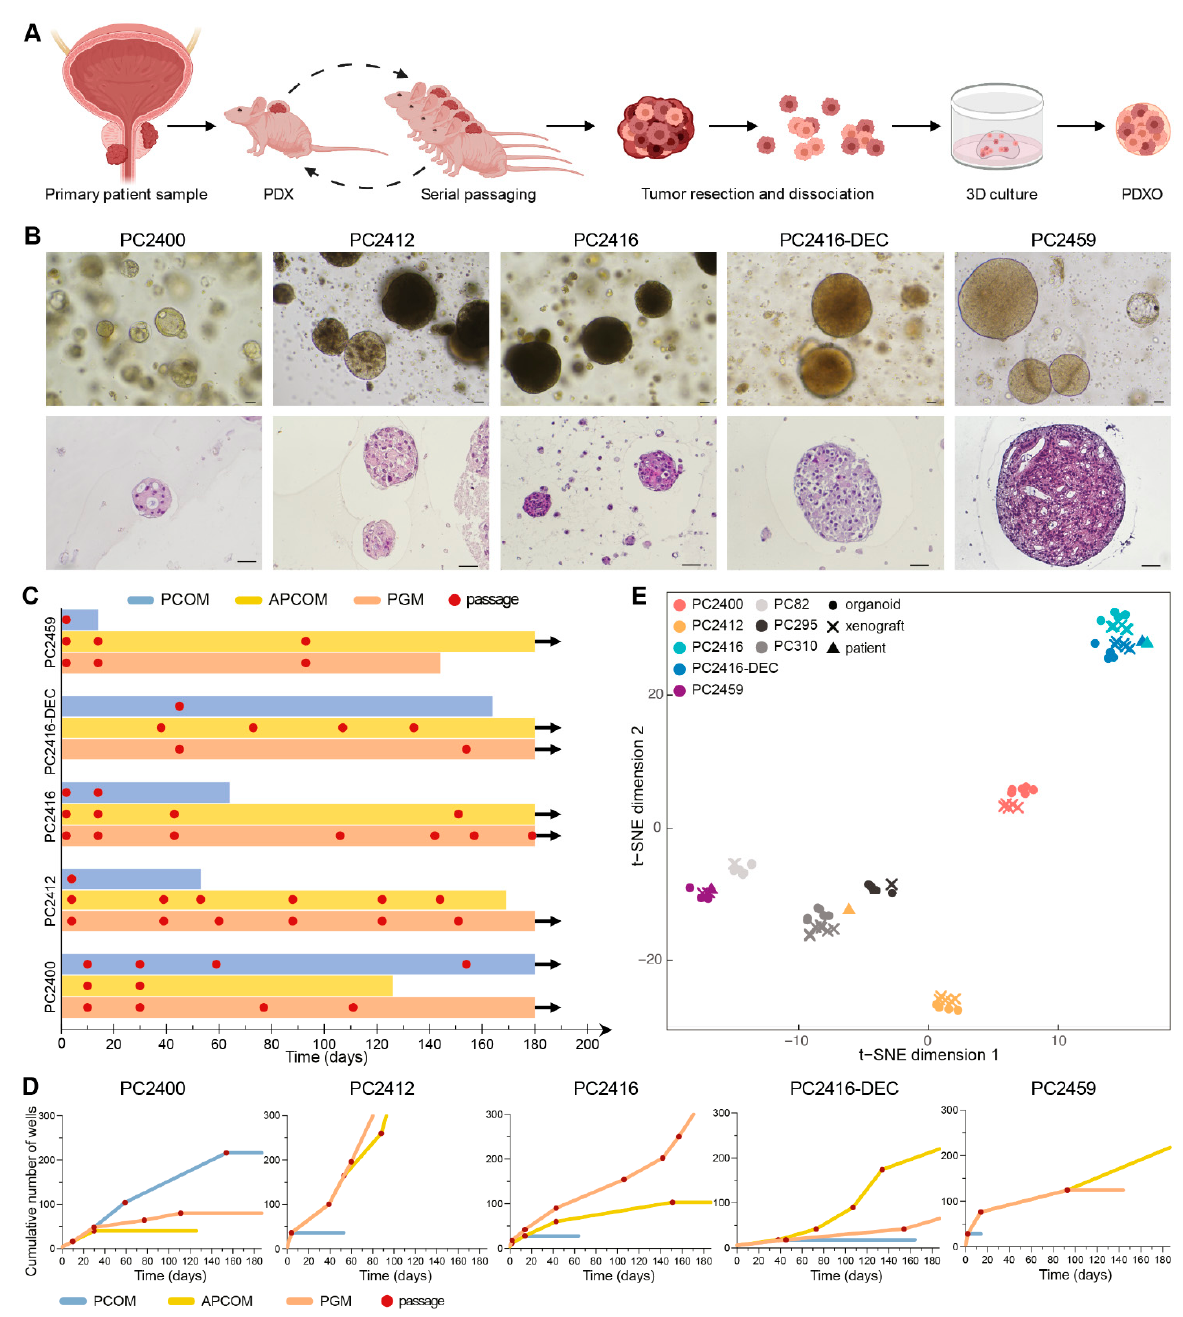
Figure 3. Establishment of PDXOs that reflect phenotypic and transcriptomic profiles of matching PDX and patient tumors. ( A ) Schematic workflow for creating PCa PDXs and PDXOs. Figure adapted from Van Hemelryk et al. [47]. ( B ) Top panel: Representative bright field images of PDXOs cultured in their optimal growth medium. Bottom panel: histological morphology of equivalent PDXOs, assessed by hematoxylin and eosin staining. Scale bars equal 50 µ m. ( C ) Swimmer’s plot visualizing the number of days PDXOs could be viably maintained in each of the three distinct organoid culture media: PCOM (blue), APCOM (yellow) and PGM (orange). Organoid passages are marked with a red dot. Arrows indicate vital organoid culture beyond 180 days of in vitro propagation. ( D ) PDXO growth curves during long-term culturing, plotted as the cumulative number of wells over time and visualized up until six months after culture initiation. Each red dot represents a passage. ( E ) t -SNE plot based on gene expression profiles of original patient samples ( n = 4), derived PDXs ( n = 34) and PDXOs ( n = 39), as quantified by RNA